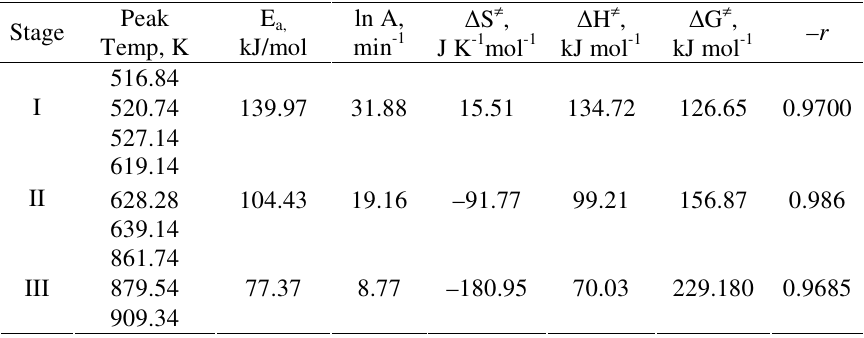
Table 7. Kinetic and thermodynamic parameters for the thermal behaviour of HBAPPA by Kissinger